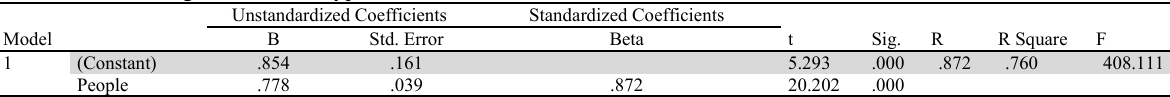
The results of testing the fifth sub-hypothesis